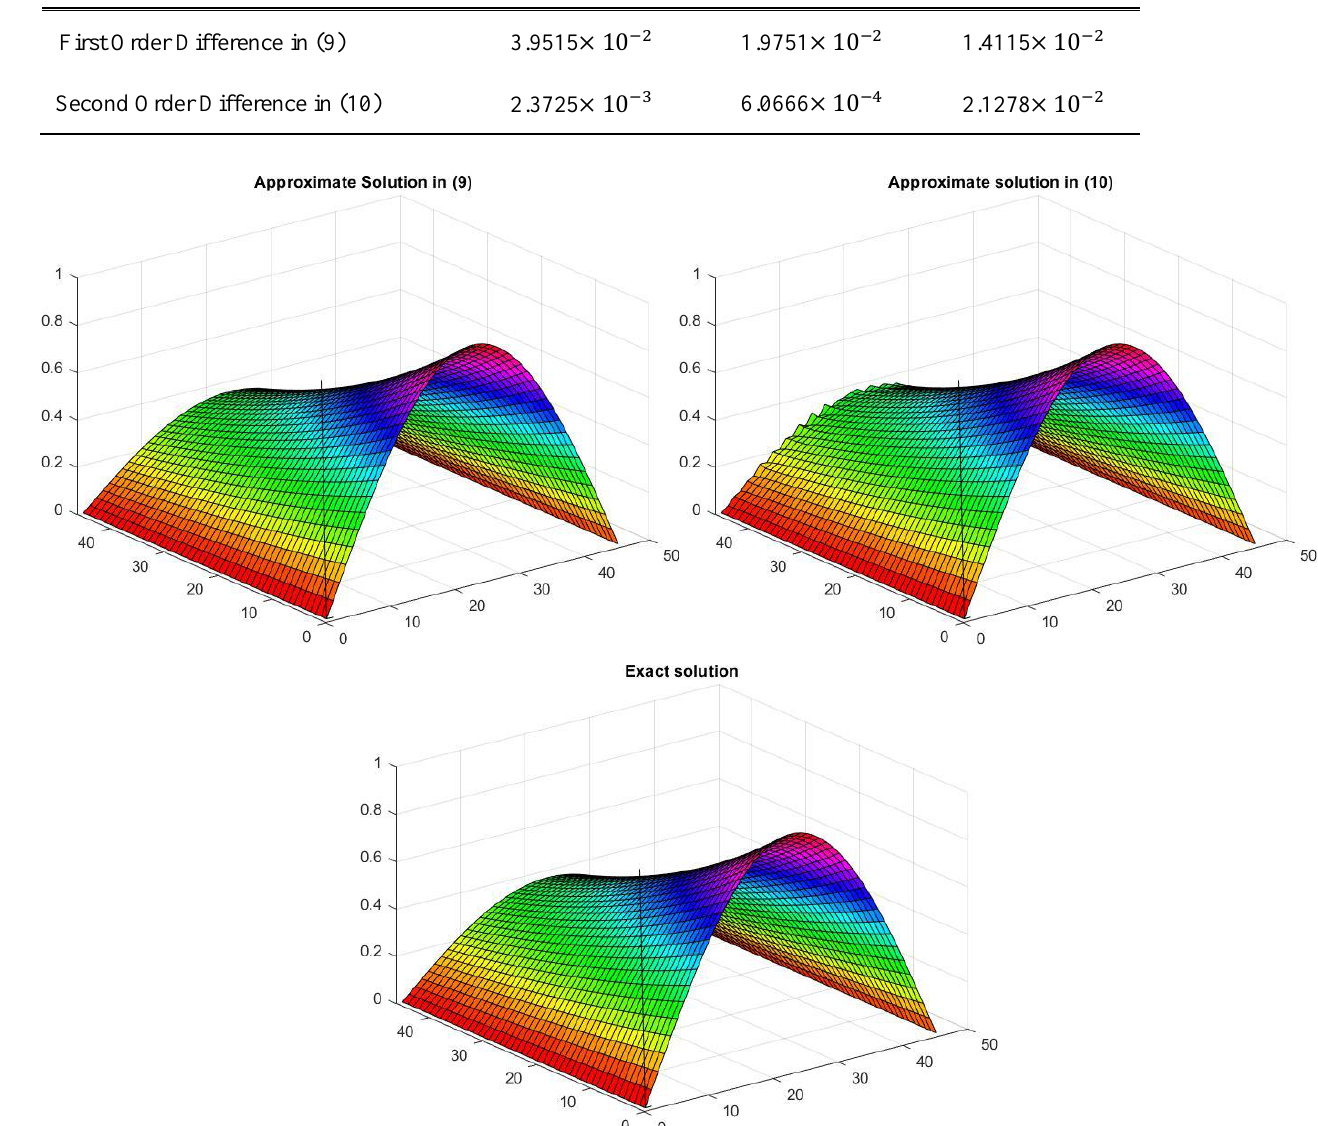
Figure 2. Exact solution and numerical solution for the problem (8) where